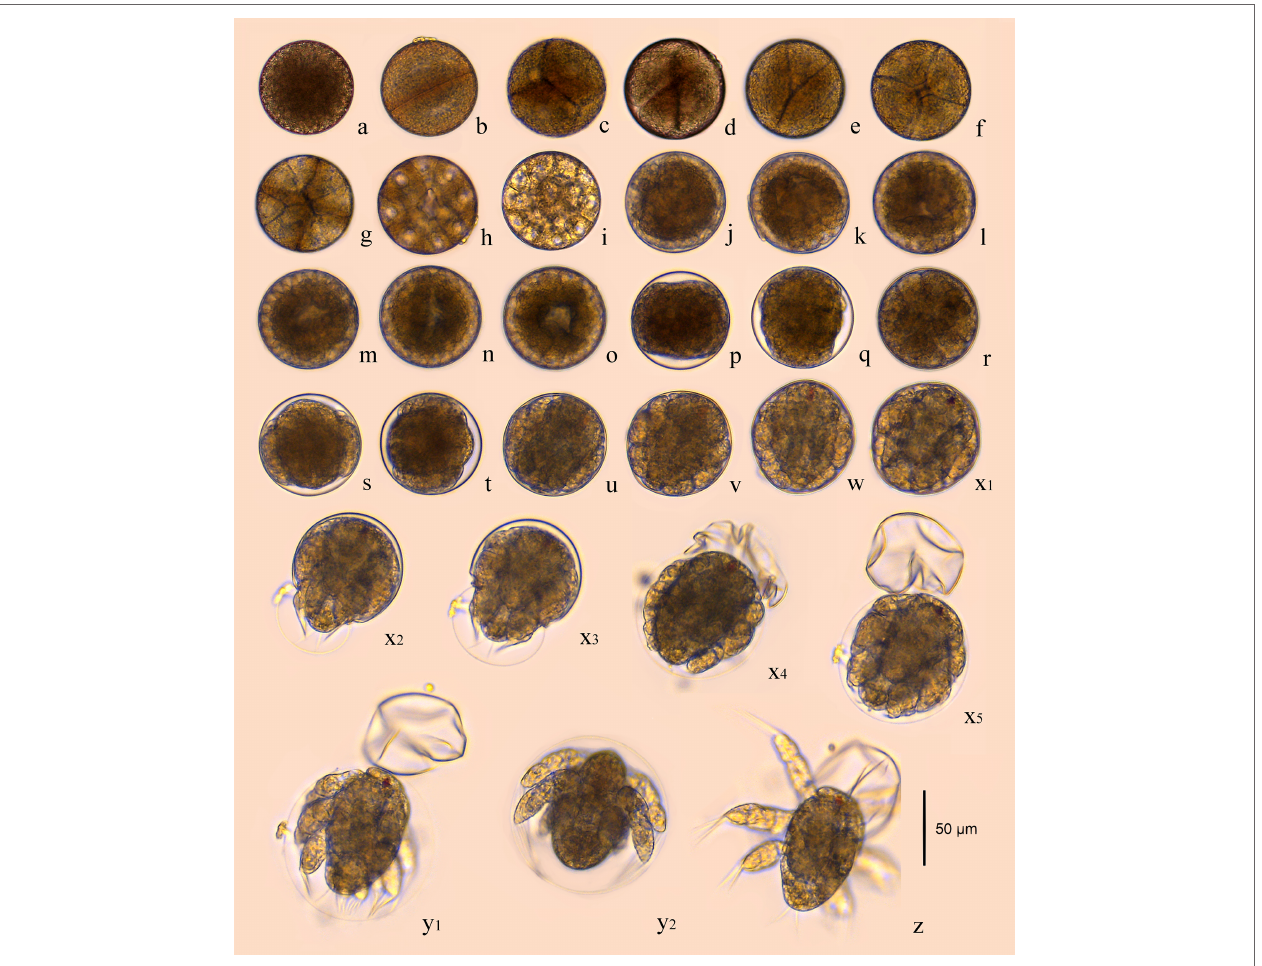
FIGURE 1 | Embryonic development of B. amoyensis . (A) , fertilized eggs; (B) , 2-cell stage; (C–E) , 4-cell stage; (F) , 8-cell stage; (G) , 16-cell stage; (H–I) , multicellular phase; (J–O) , grastrula stage; (P–Q) , no structure visible; (R–T) , limb bud stage; (U–W) , the early stage of nauplii; (X1–X5) , the rupture stage of outer membrane; (Y1–Y2) , the rupture stage of inner membrane; (Z) , the first stage of